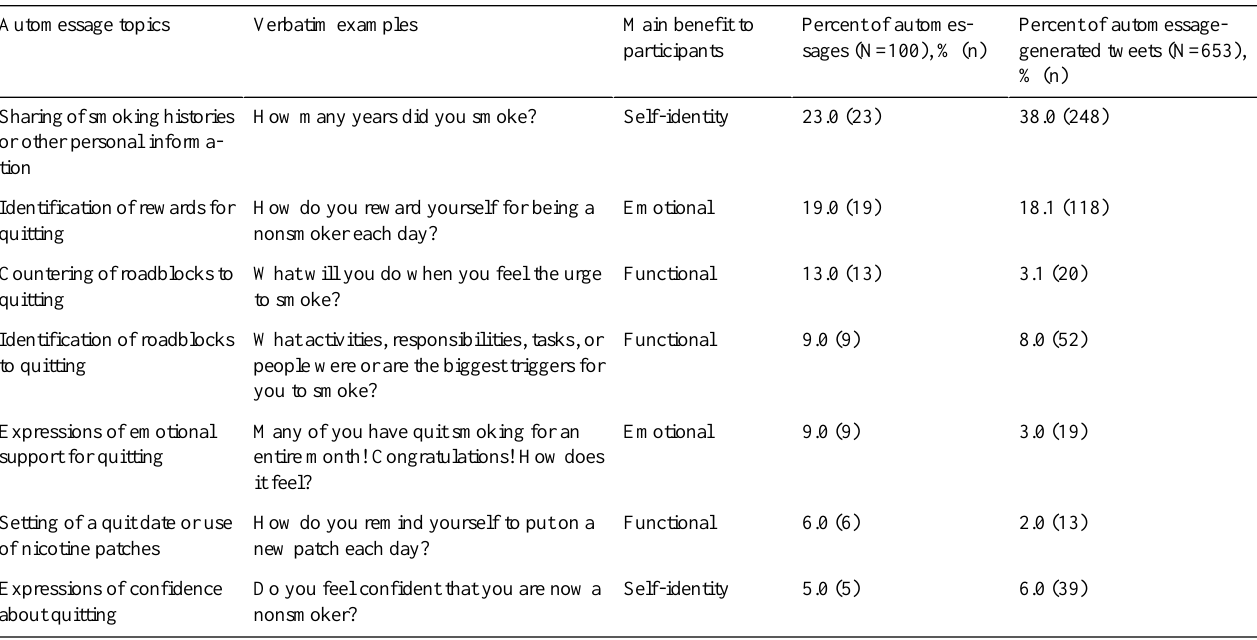
Table 1. Automessage topics versus automessage-generated tweets a .